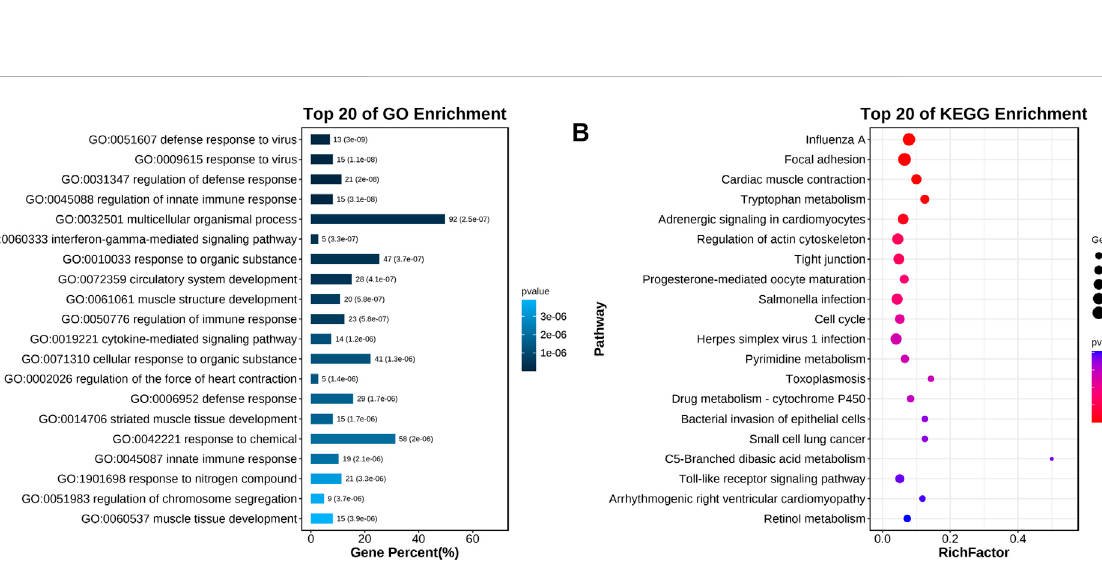
FIGURE 3 Functional enrichment of DEGs between miR-499-5p overexpressing and NC CPMs. (A) Top 20 signi fi cantly enriched GO-BP terms; (B) Top 20 signi fi cantly enriched KEGG